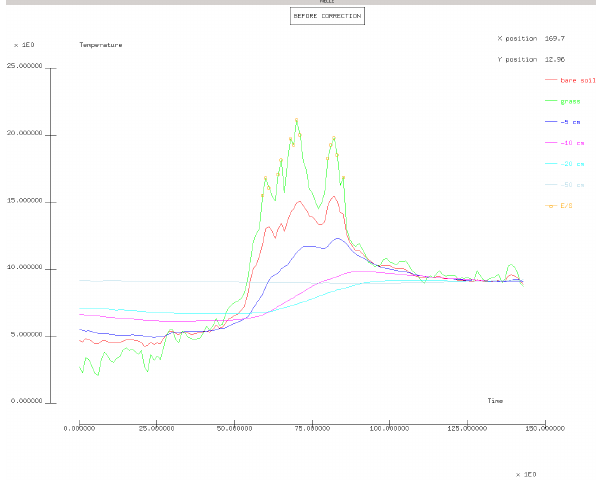
Figure 5. Visualization of the automated QC applied on the 10-min soil/grass temperatures records performed on 22 November 2014 at the Melle station (AWS 6434, see Table 1). Erroneous grass tem- perature data are indicated by a orange circle on the green curve.